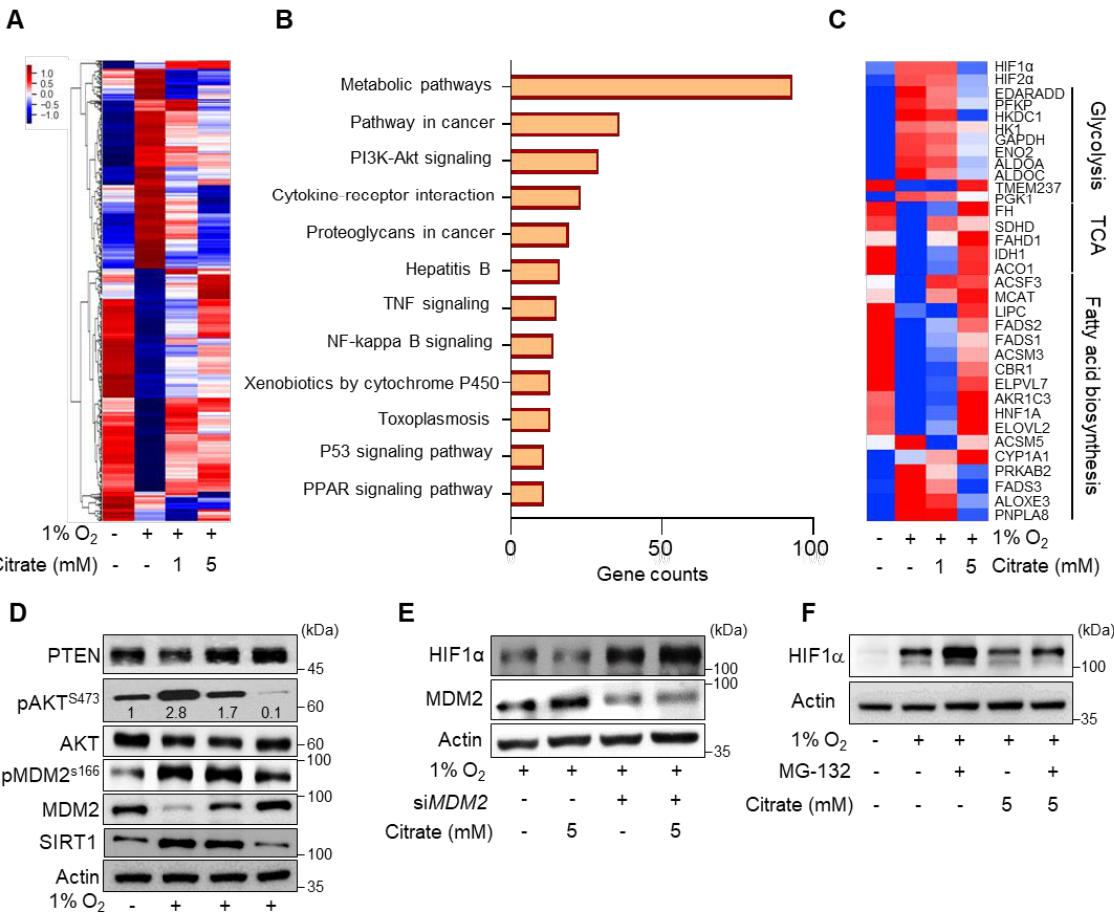
Figure 3. Effect of citrate treatment on HIF1 α expression. ( A ) Heat-map representing color-coded expression levels of differentially expressed genes ( p > 0.05, normalized data(log2) > 4, up- or downregulated > 1.5-fold) in HepG2 cells after treatment with or without citrate treatment under 1% O 2 for 24 h. ( B ) Top 12 significantly enriched pathways of differentially expressed genes associated with citrate treatment under hypoxic conditions as analyzed by the Kyoto Encyclopedia of Genes and Genomes pathway analysis. ( C ) Heat-map of dysregulated genes related to glycolysis, TCA cycle, and fatty acid biosynthesis after treatment with the same as ( A ). ( D ) PTEN, phosphor (p) AKT (S473), AKT, MDM2, pMDM2 (S166), SIRT1, and β -actin expression levels in HepG2 cells after incubation with citrate (0, 1, or 5 mM) under 21% or 1% O 2 for 24 h. ( E ) HIF1 α , MDM2, and β -actin expression levels in HCC cells after transfection with siRNA oligos against MDM2 (si MDM2 ) or scrambled siRNA oligos for 24 h incubation upon indicated condition. ( F ) HIF1 α and β -actin expression levels in HepG2 cells after treatment with citrate and MG-132 under 21% or 1% O 2 for 8 h. Full Western Blot images can be found in Figure